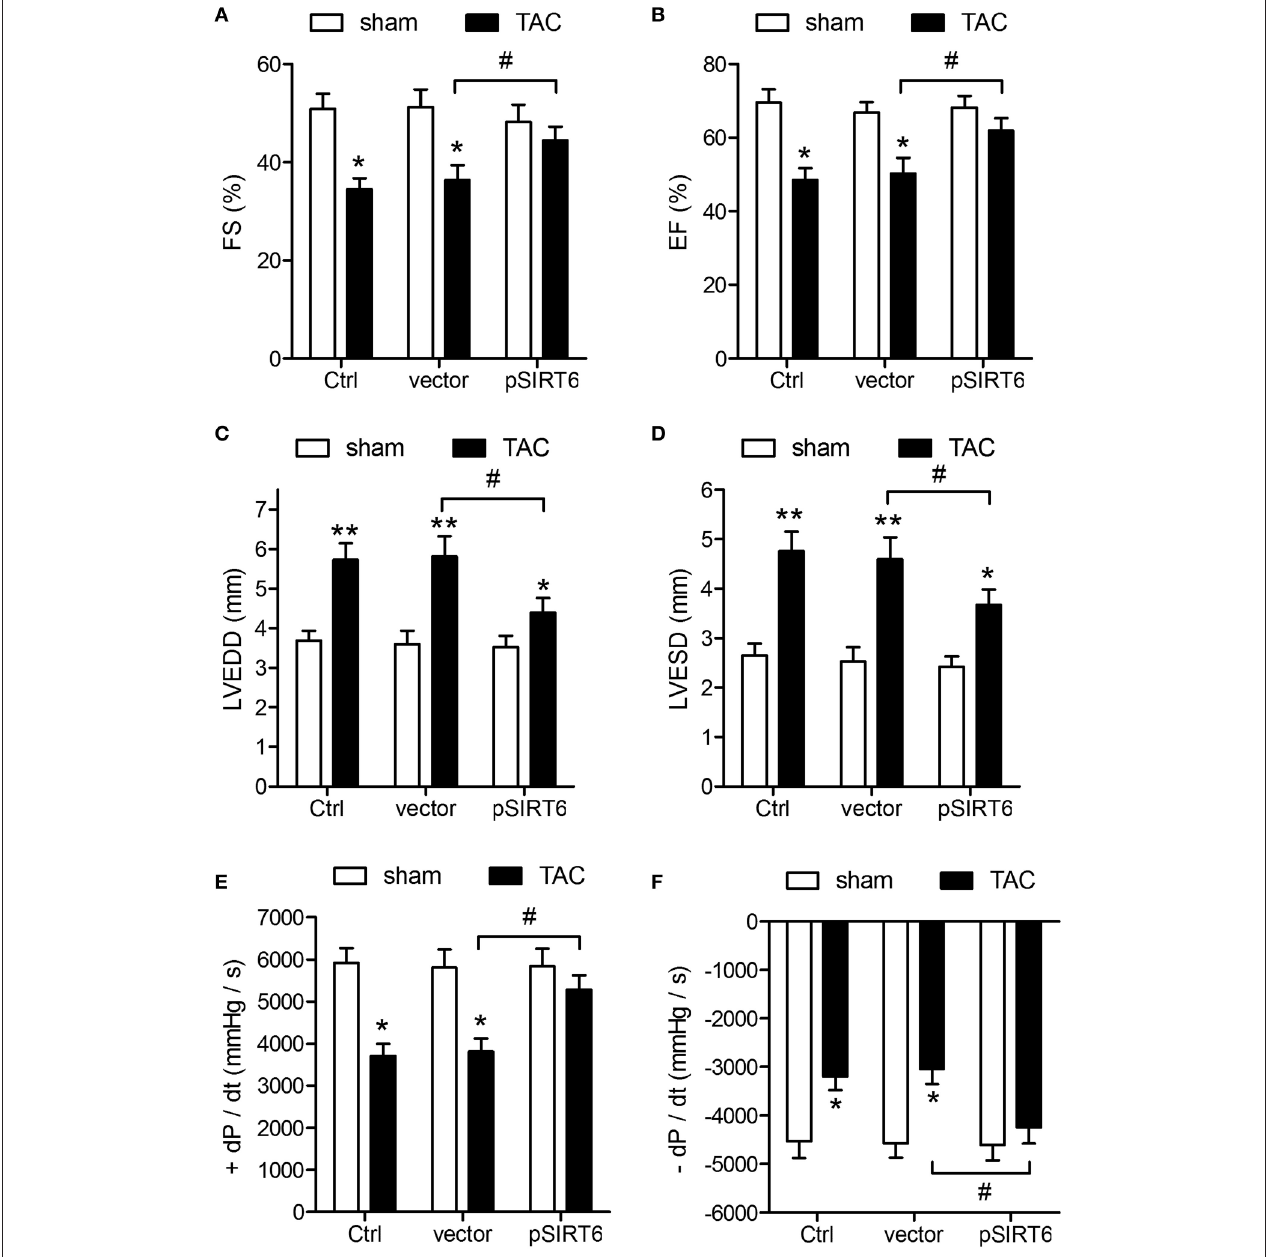
FIGURE 3 | SIRT6 overexpression protects against TAC-induced impairment of cardiovascular function. Echocardiographic and hemodynamic measurements of fractional shortening (FS) (A) , ejection fraction (EF) (B) , left ventricular end-diastolic dimension (LVEDD) (C) , left ventricular end-systolic dimension (LVESD) (D) , rates of maximal rise in left ventricular pressure ( + dP/dt) (E) , and rate of maximal fall in left ventricular pressure ( − dP/dt) (F) in control, vector and pSIRT6-injected mice at 28 days after TAC or sham surgery. * P < 0.05, ** P < 0.01 vs. sham group, # P < 0.05. n = 12 per